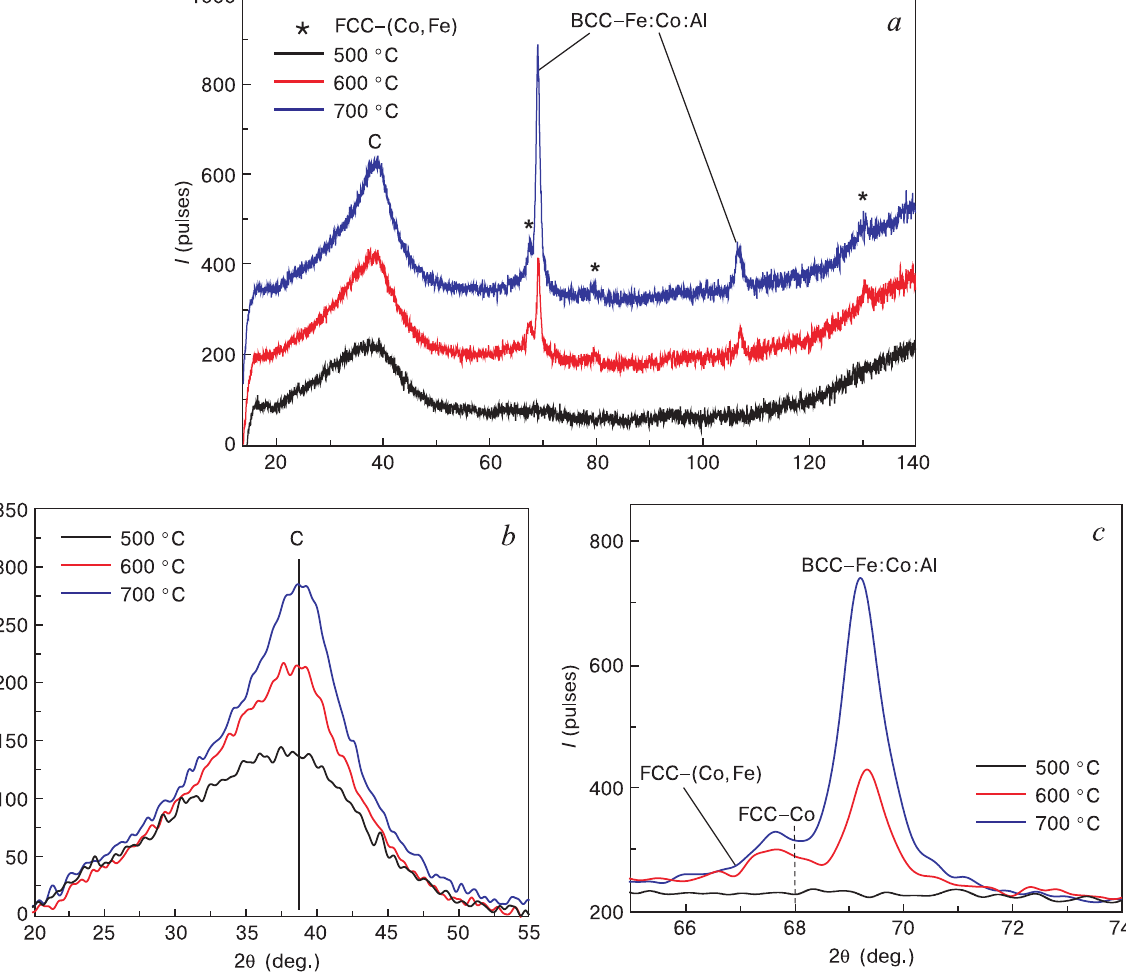
Figure 1. ( a ) X-ray diffraction patterns of FeСoAl/С nanocomposites synthesized at different temperatures, ( b ) fragments of X-ray patterns in the vicinity of the angular range for the graphite (002) plane and ( c ) for the (111) and (110) planes of the metallic